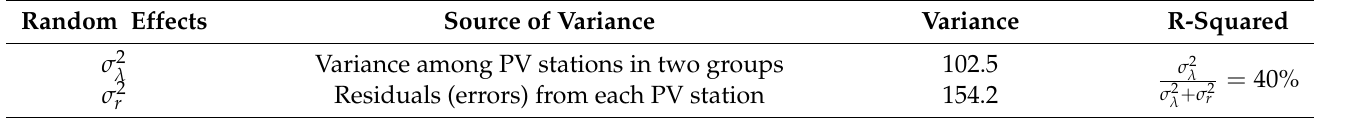
Table 4. The random-effects results of the average model based on the MEM in Equation